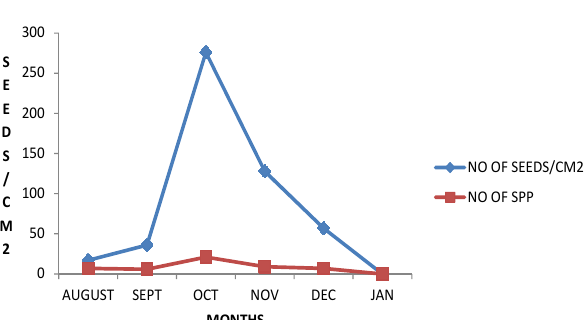
Fig. 5. Monthly emergence of seedlings and species at both depths from the rainy season in riparian